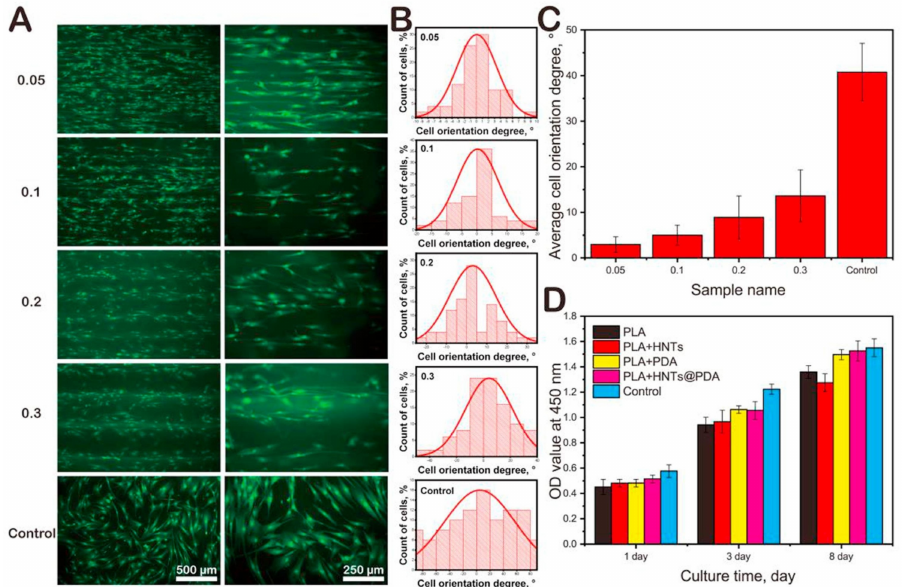
Figure 25. ( A ) hMSC seeded over PLA/HNT 3D printed scaffolds and stained with fluorescein isothiocyanate. Authors reported different stripe widths. ( B ) Cell counting and orientation degree; the average cell orientation degree was summarized in ( C ). ( D ) Results of cell proliferation (CCK- 8) for 1, 3 and 8 days. OD stands for “optical density” quantified at 450 nm. Reproduced with permission from [140], Elsevier,